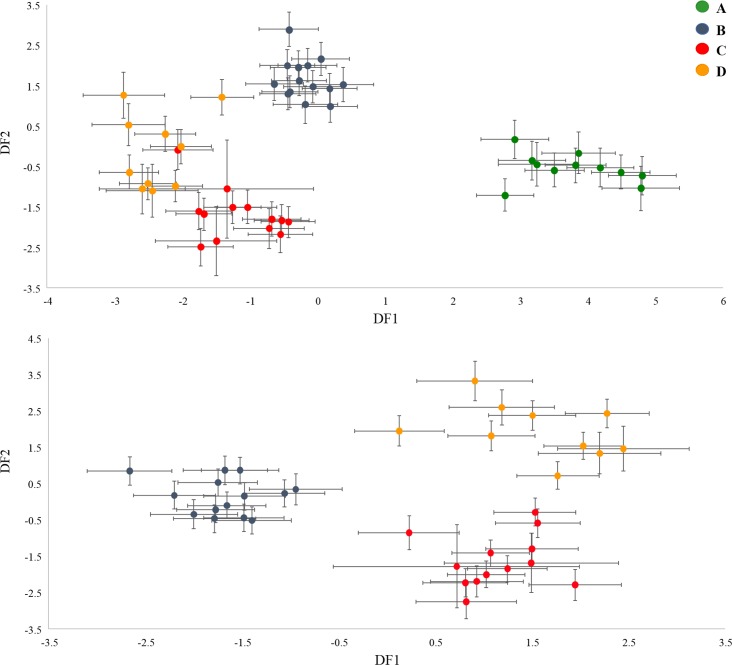
Analysis of the association between molecular species delimitation and morphometry.Scatterplot showing the discrimination of species groups based on the canonical discriminant functions of the discriminant analysis performed on all measured individuals of the studied clones (upper) for species ‘A’, ‘B’, ‘C’, ‘D’ and (lower) for species ‘B’, ‘C’, ‘D’. Error bars represent variation between individuals of the same clone (twice the standard error of the mean).